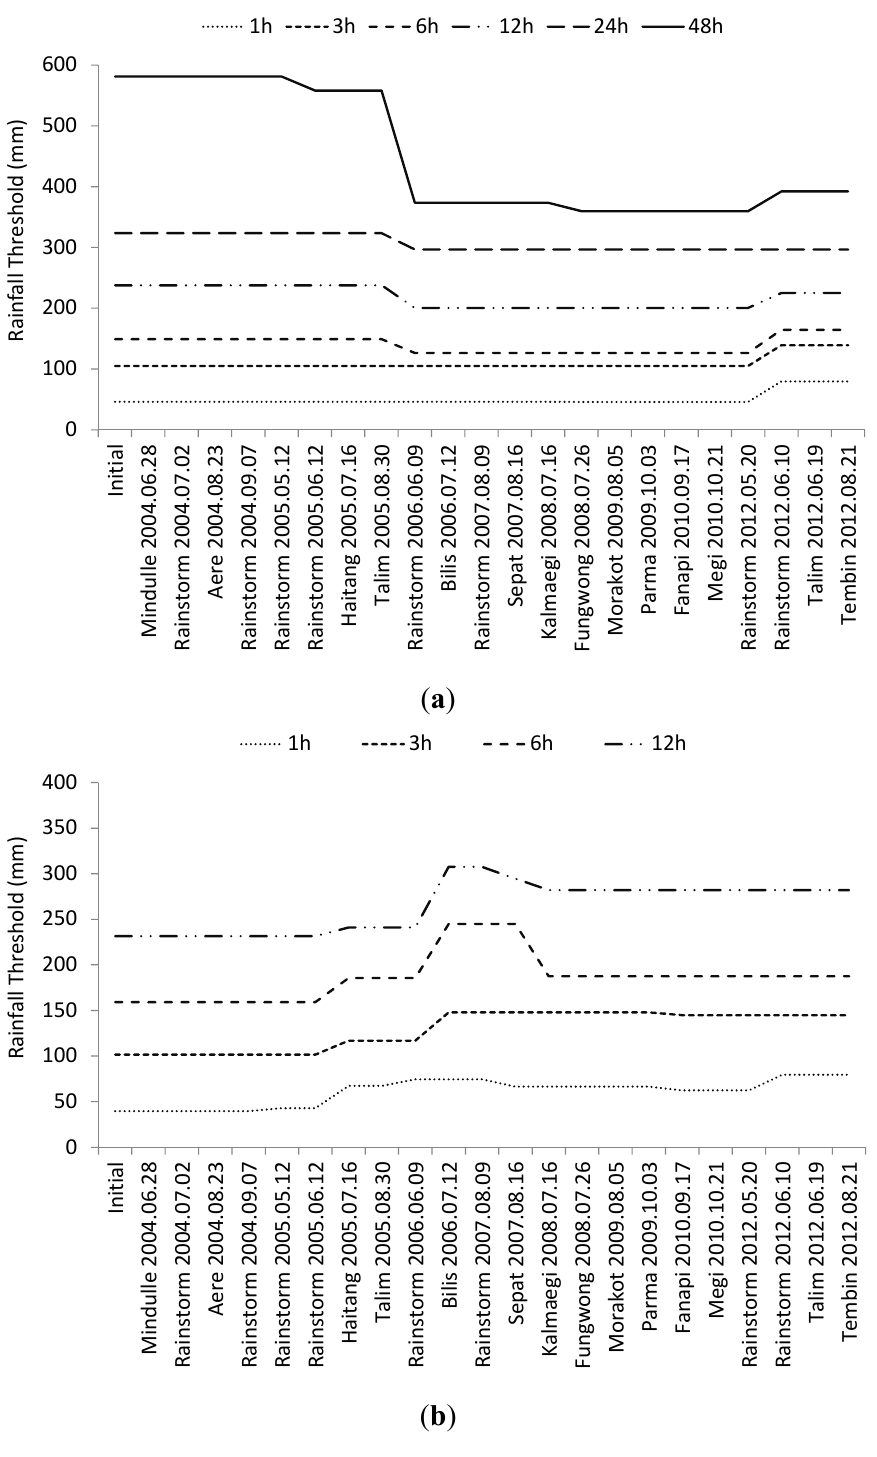
Figure 5. Updating process of rainfall thresholds for ( a ) Sinyuan and ( b ) Linluo